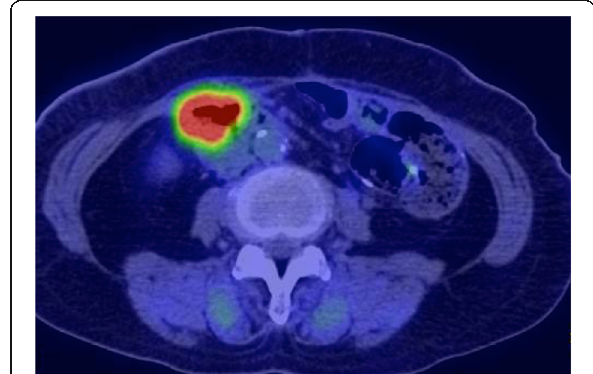
Fig. 3 18-Fluorodeoxyglucose positron emission tomography/CT showed abnormal uptake in the tumor and widely bordering abdominal